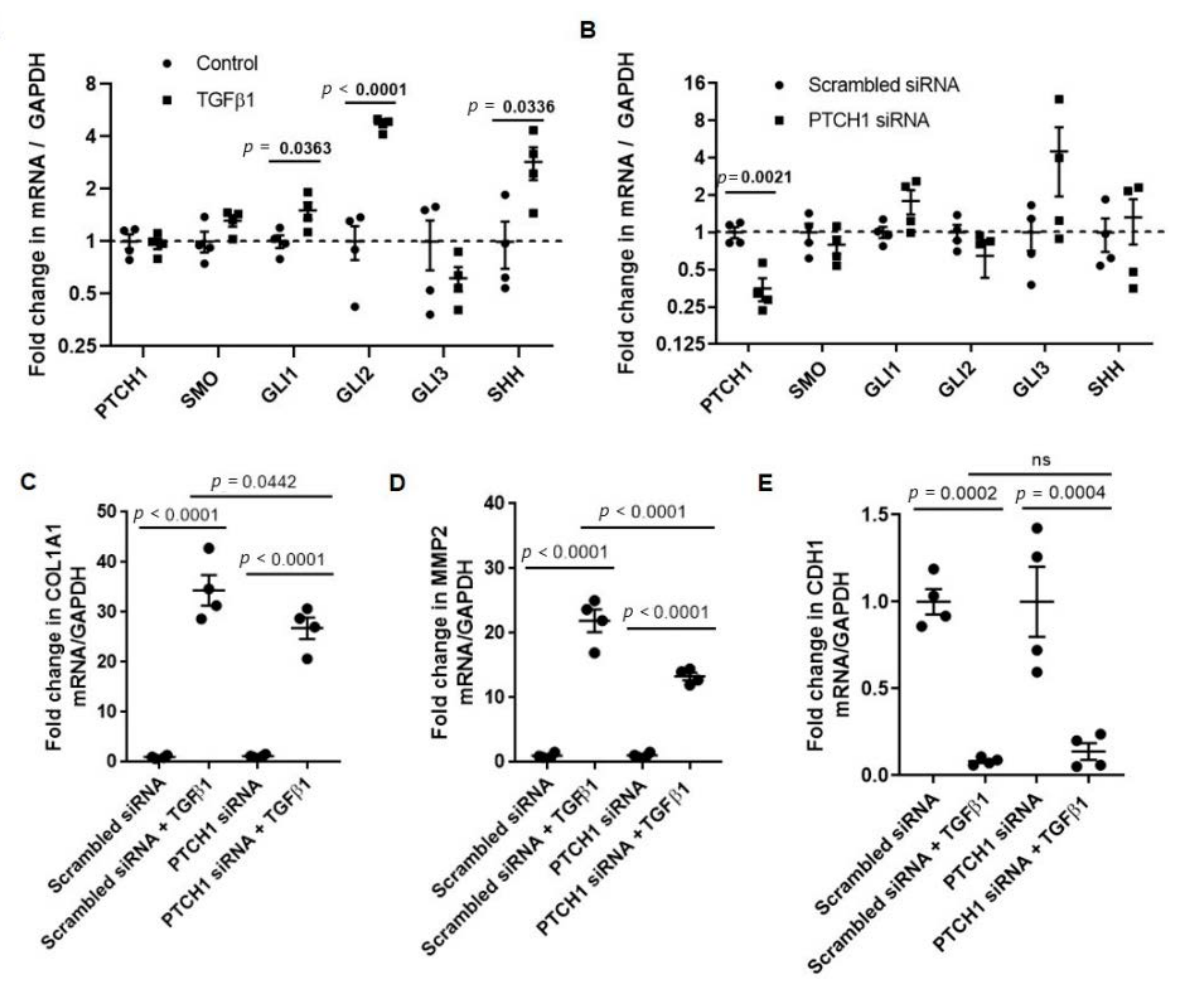
Figure 1. PTCH1 gene silencing attenuates TGF β 1-induced increase in COL1A1 and MMP2 gene expression in 1HAE o cells. Fold change in PTCH1 , SMO , GLI1 , GLI2, GLI3 and SHH gene expression normalized to GAPDH in 1HAEo cells treated with ( A ) TGF β 1 compared to untreated controls and ( B ) PTCH1 siRNA compared to scrambled siRNA were shown. Fold changes in ( C ) COL1A1 , ( D ) MMP2, ( E ) and CDH1 gene expression normalized to GAPDH were assessed in cells treated with scrambled or PTCH1 siRNA in the absence or presence of TGF β 1 treatment. ns = not statistically significant. Values were expressed as mean ± SEM ( n = 4 independent experiments conducted at different passages). Parametric t -test was used in each gene in panel ( A ). One-way analysis of variance with Bonferroni’s multiple comparisons test was used in panels ( B – D